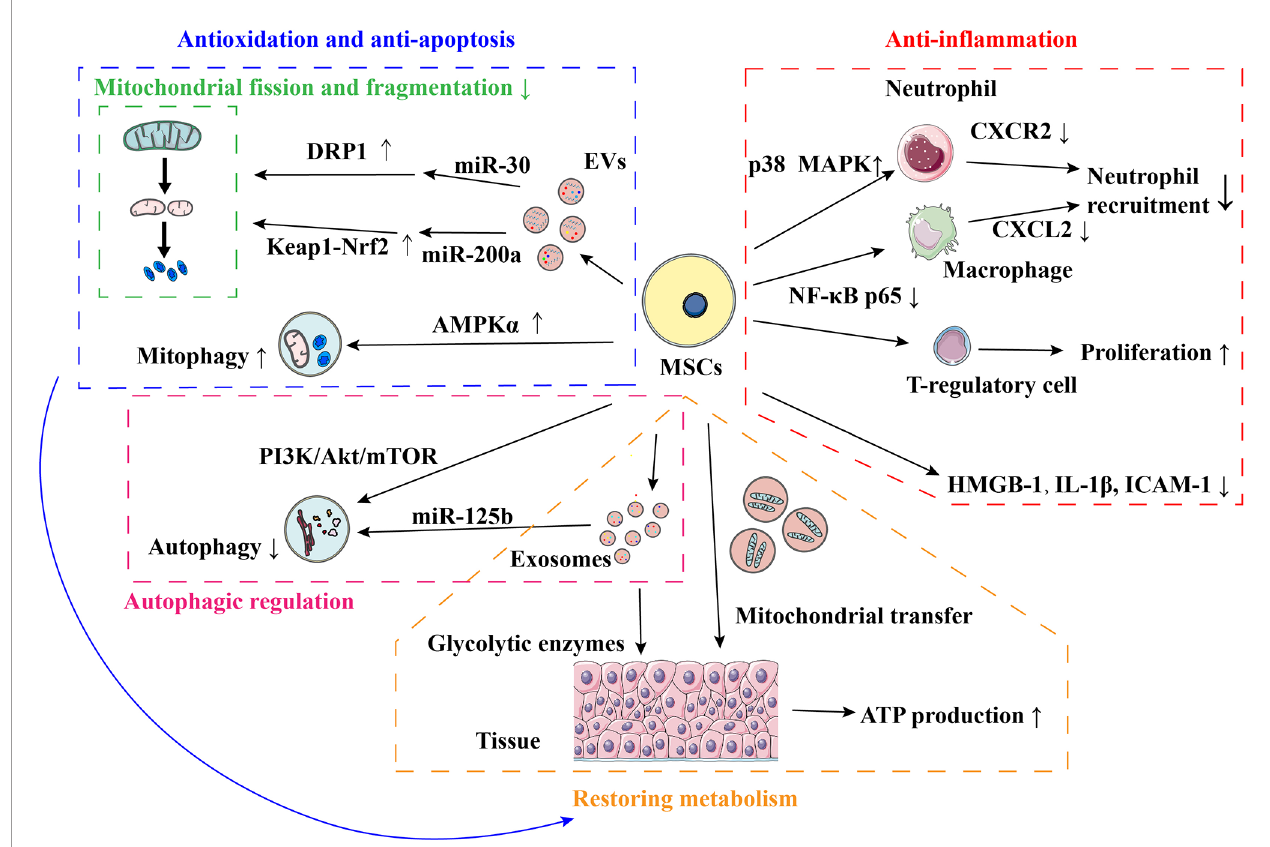
FIGURE 1 | Mechanisms of MSCs in ameliorating organ IRI. AMPK, Adenosine monophosphate-activated protein kinase; ATP, Adenosine triphosphate; CXCL, CXC chemokine ligand; CXCR, CXC chemokine receptor; DRP1, Dynamin-related protein 1; EVs, Extracellular vesicles; HMGB-1, High mobility group box chromosomal protein-1; ICAM-1, Intercellular adhesion molecule-1; IRI, Ischemia-reperfusion injury; Keap1, Kelch-like ECH-associated protein 1; MAPK, Mitogen-activated protein kinase; NF- k B, Nuclear factor-Kb; Nrf2, NF-E2-related factor 2; IL, Interleukin; MSCs, Mesenchymal stem cells; PI3K, Phosphatidylinositol 3-kinase; mTOR, Mechanistic target of